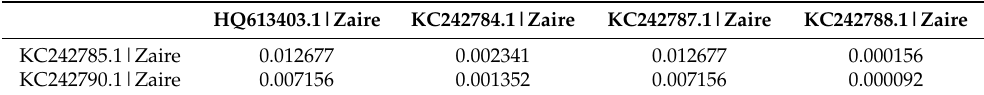
Table 3. The p-values for testing the nucleotide substitution number between sequences in the third clade for the maximum likelihood tree based on the K80 model.